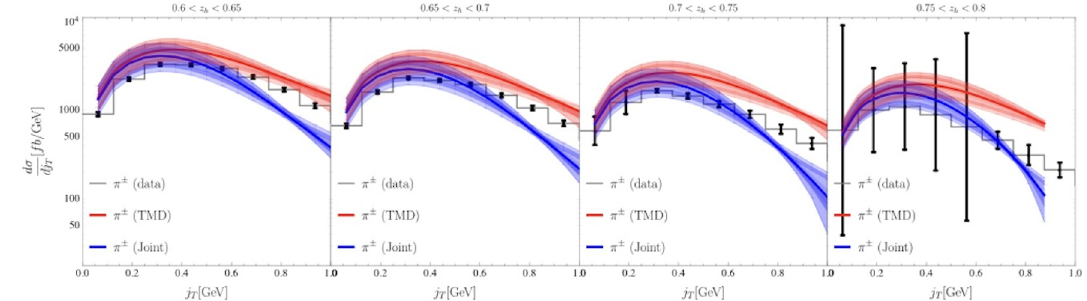
Figure 4 . Transverse momentum j T distribution given by TMD resummation (red band) and the joint TMD and threshold resummation (blue band) for the charged pion production with z h bins 0 . 65 < z h < 0 . 7 , 0 . 7 < z h < 0 . 75 , 0 . 75 < z h < 0 . 8 and 0 . 8 < z h < 0 . 85 from left to right. Results are shown in comparison with Belle data [48] in each